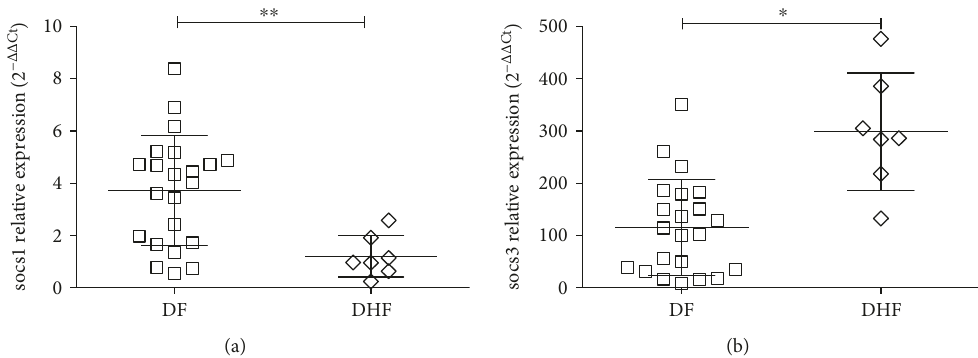
Figure 2: Relative expression of socs genes in patients with dengue. The relative expression of socs1 and socs3 mRNA was determined in PBMC of patients with DF and DHF. Results are expressed as fold increments compared with the expression level of the control group which was assigned an arbitrary value of 1. Error bars represent mean ± S.D. Signi fi cant di ff erences ∗ P < 0 05 ; ∗∗ P < 0 01 by Mann – Whitney U test for continuous variables.